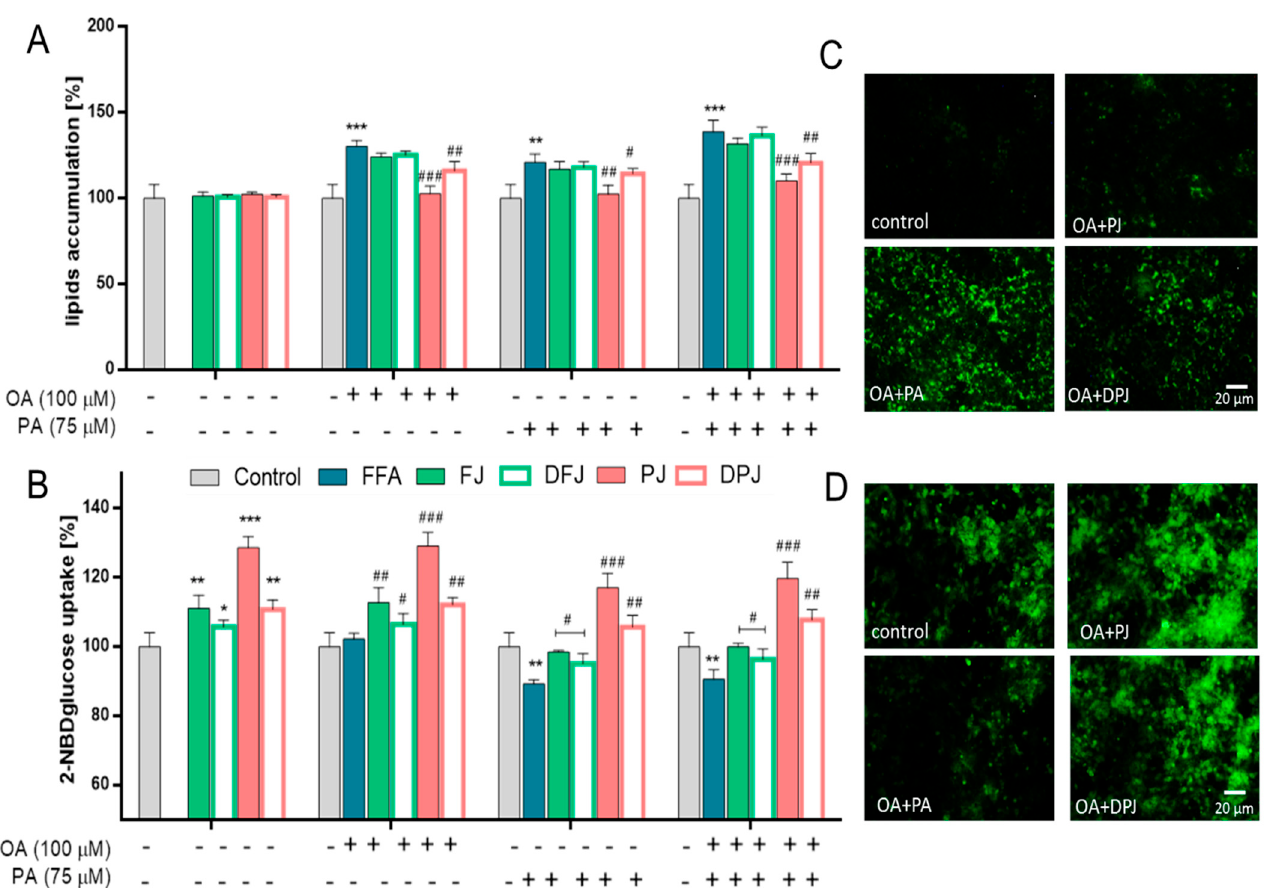
Figure 5. The influence of V. opulus fresh juice (FJ), digested fresh juice (DFJ), purified juice (PJ), and digested purified juice (DPJ) on the accumulation of lipid droplets ( A ) and the effect on fluorescent glucose analog 2-NBDG uptake ( B ) in L6 cells after 24 h co-incubation of cells with oleic acid (100 µM) and/or palmitic acid (75 µM); control cells were not exposed to any compound except vehicle; values are means ± standard deviations from at least five independent experiments, n ≥ 9; statistical significance was calculated versus control cells (untreated), * p ≤ 0.05, ** p ≤ 0.01, *** p ≤ 0.001 and versus positive cells (treated with fatty acids), # p ≤ 0.05, ## p ≤ 0.01, ### p ≤ 0.001. Cells visualized under fluorescent microscope at 200 × magnification with FITC filter after Nile Red staining ( C ) and after 2-NBDG uptake ( D ).